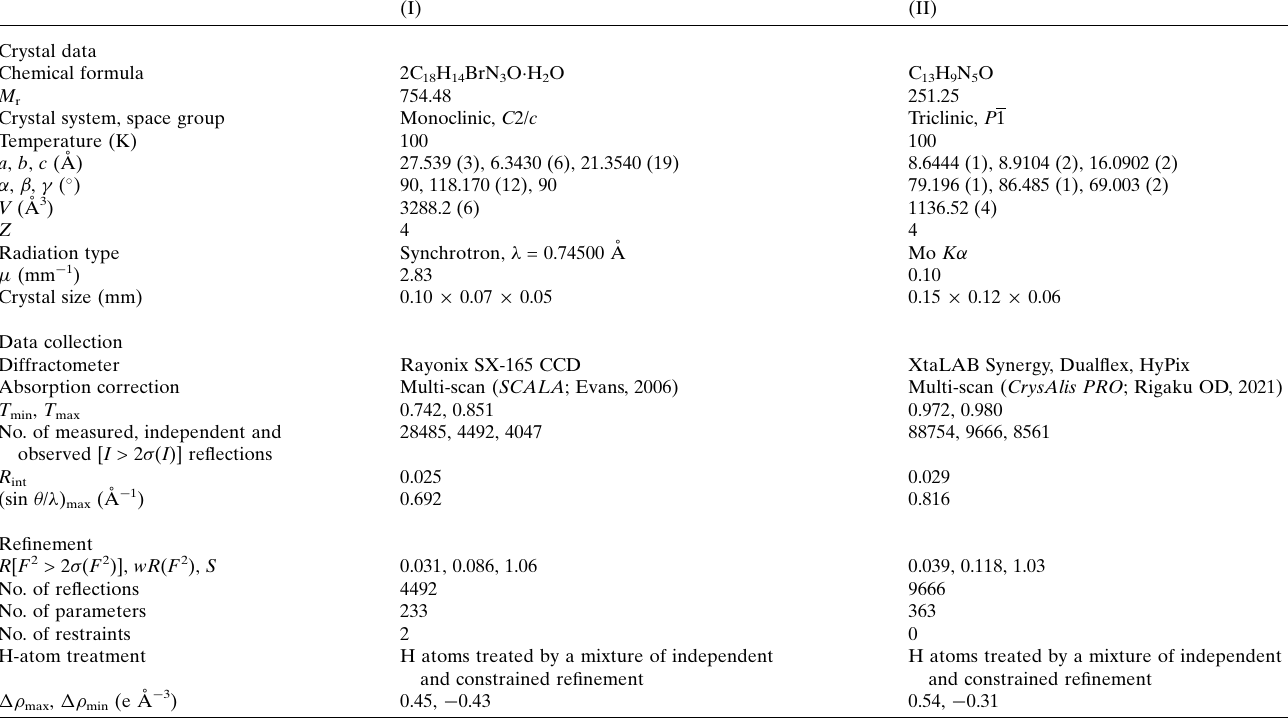
Table 7 Experimental